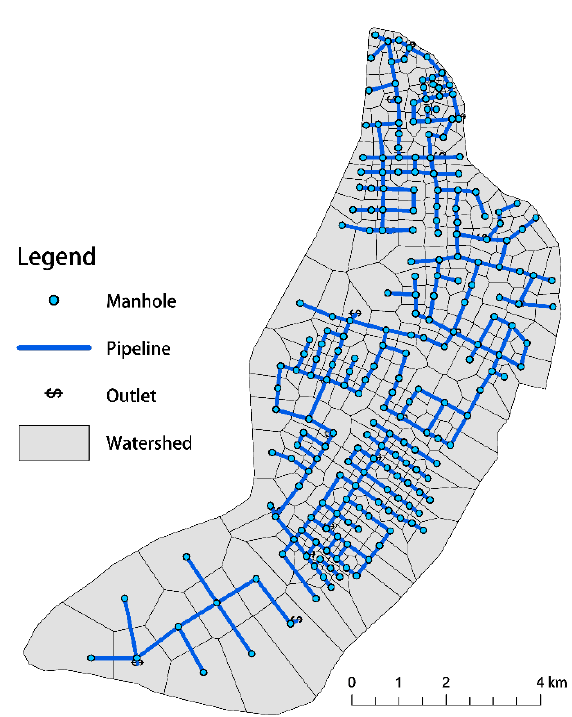
Figure 4. Pipeline network drainage model of study area.